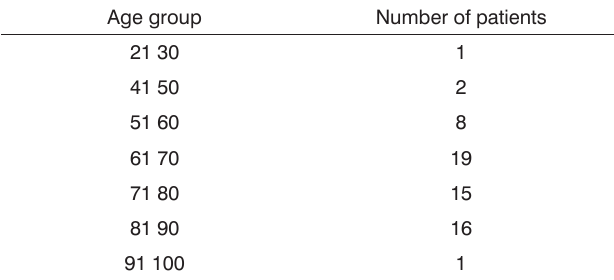
Table 1 shows the number of patients according to age groups (10-year Table 1. Distribution of patients according to age groups.